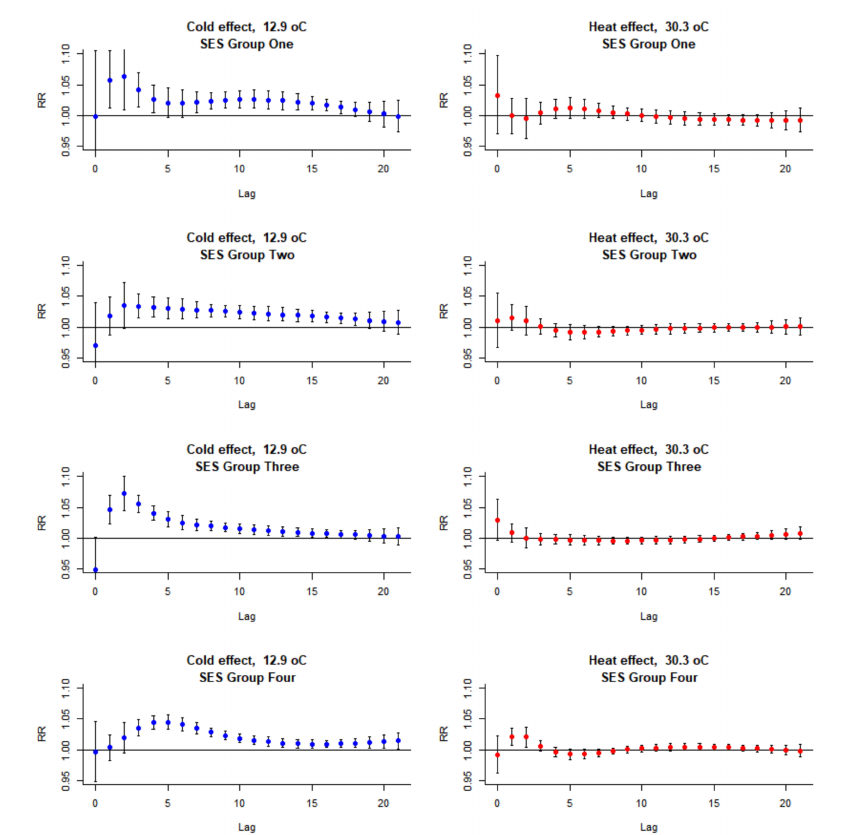
Figure 3. The Lag–response e ff ect distribution during the 21 days lag period after exposed to a low (12.9 ◦ C, 2.5th percentile) and high (30.3 ◦ C, 97.5th percentile) temperature compared to reference temperature (27 ◦